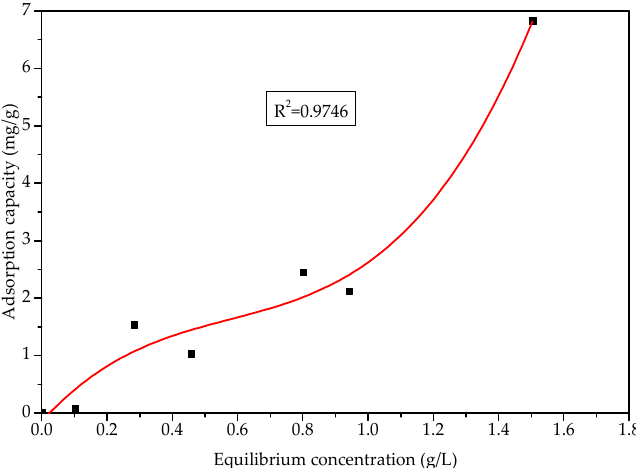
Figure 11. Adsorption isotherms of the asphalt–steel slag.